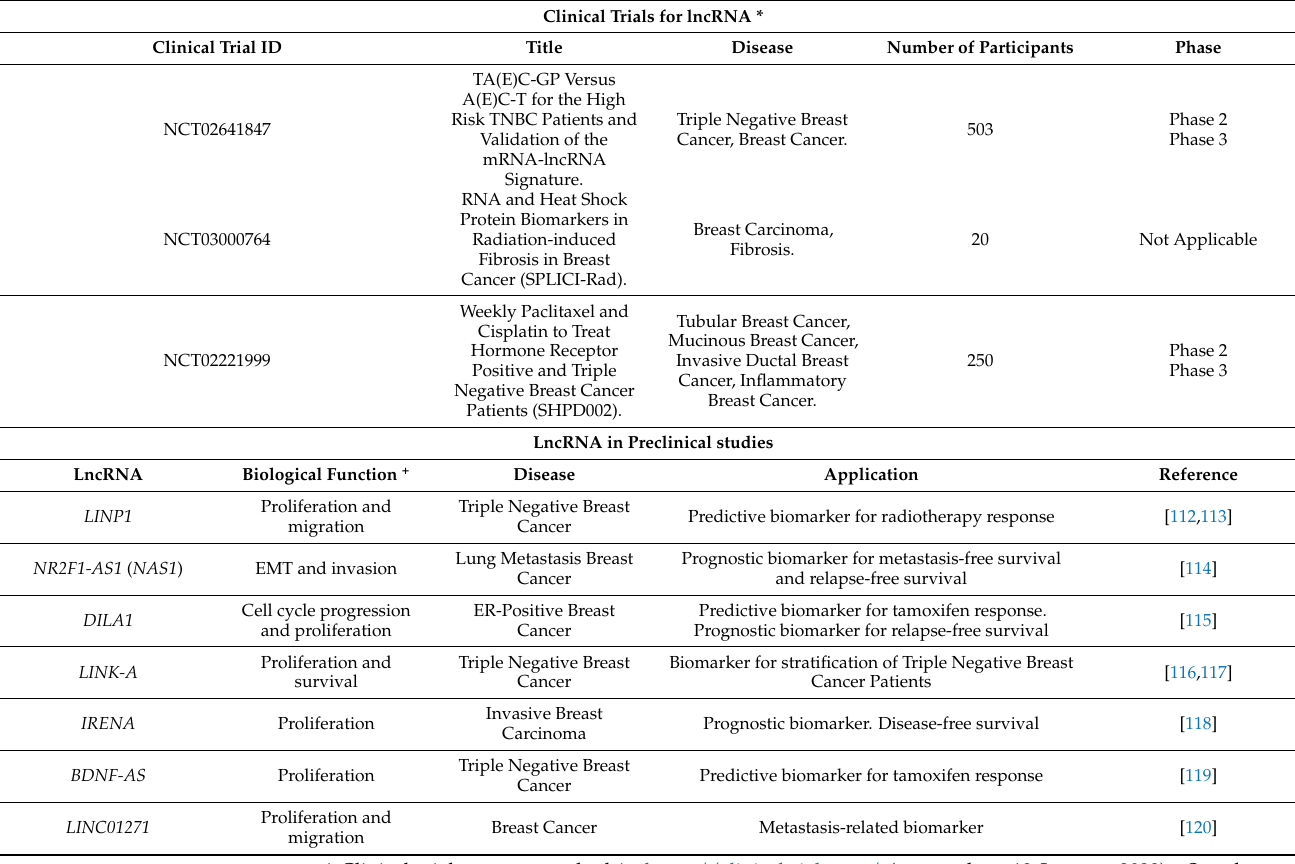
Table 1. List of clinical trials and preclinical studies in breast cancer research that also included lncRNAs. Clinical Trials for lncRNA